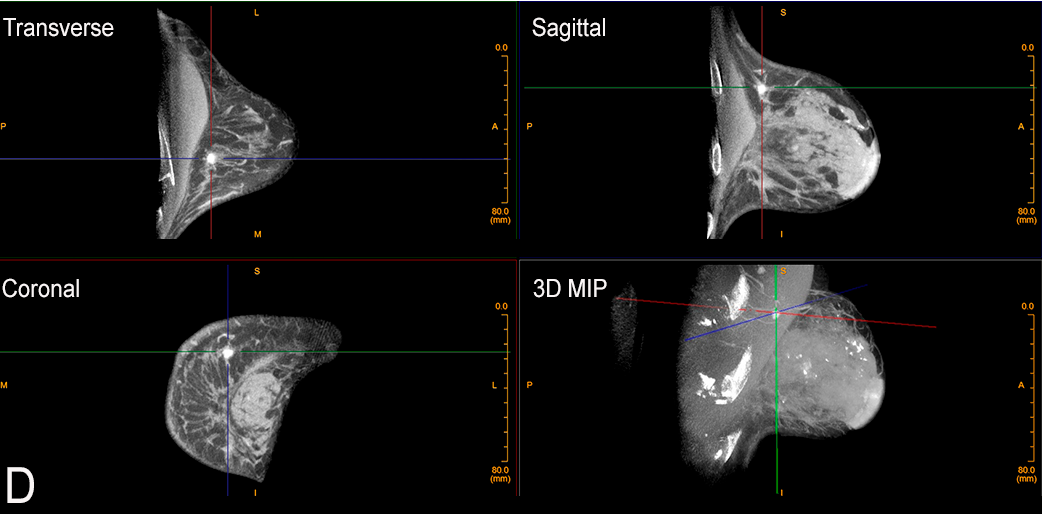
Figure 4. Calcifications on CBBCT. Left CC ( A ) and MLO ( B ) views demonstrate pleomorphic micro-calcifications (arrow). ( C ) Unenhanced CBBCT images showing calcifications, which are marked with grid lines. ( D ) Contrast-enhanced CBBCT in the same patient showed an incidental mass marked with grid lines.